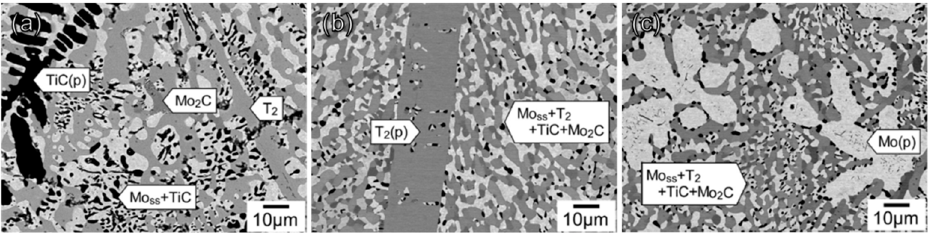
Figure 3. SEM-BSE images of microstructures for ( a ) Mo–5.0Si–10.0B–10.0Ti–10.0C; ( b ) Mo–6.7Si– 13.3B–7.5Ti–7.5C; ( c ) Mo-5.0Si–10.0B–7.5Ti–7.5C (at.%) alloys after heat treatment at 1800 °C for 24 h [31].